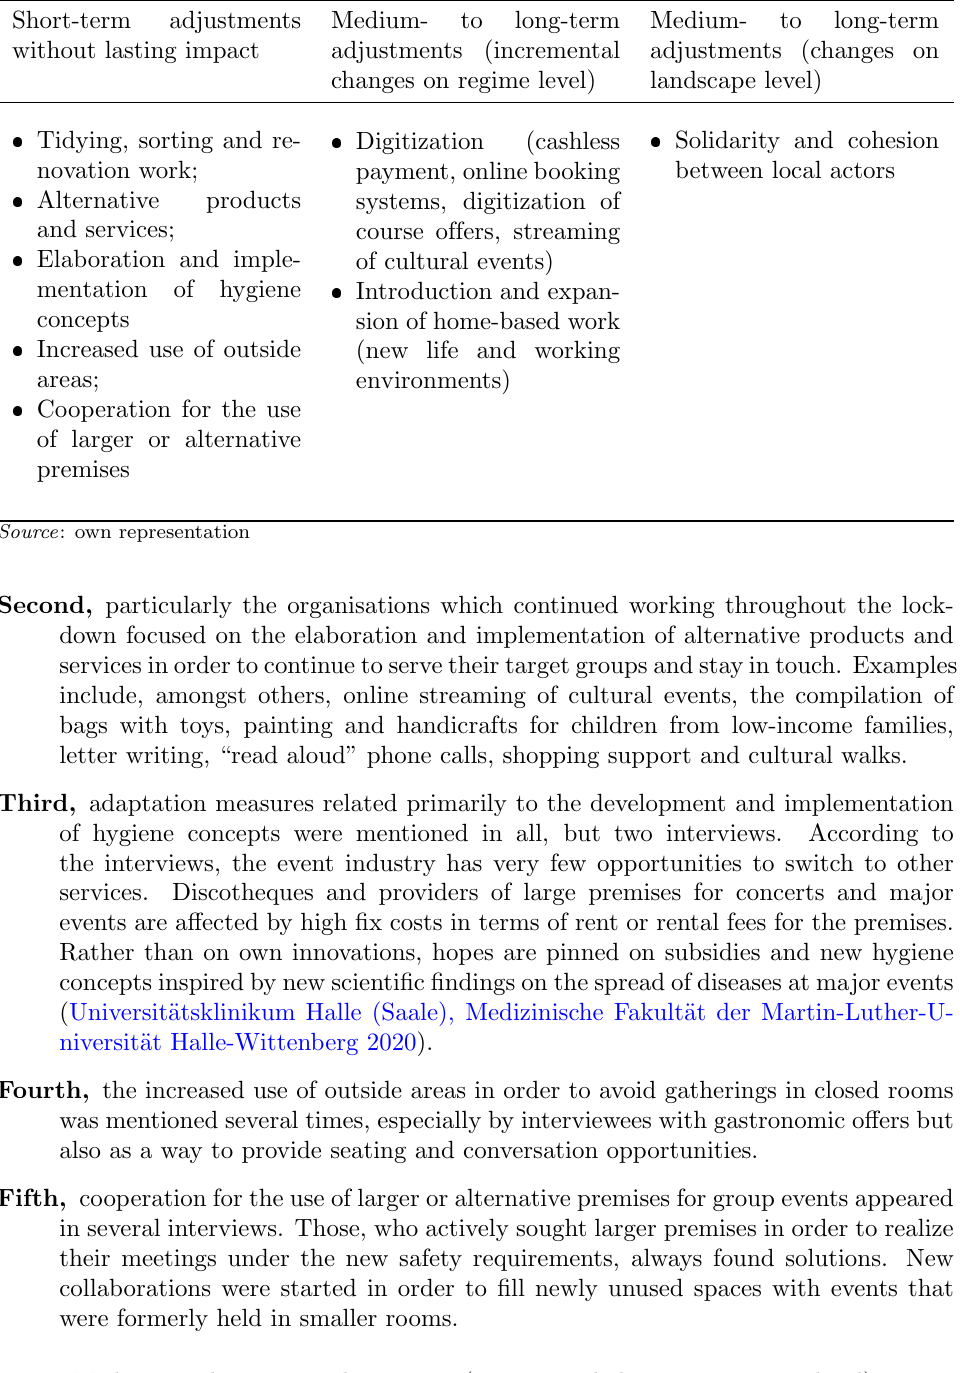
Medium- to long-term adjustments (incremental changes on regime level)